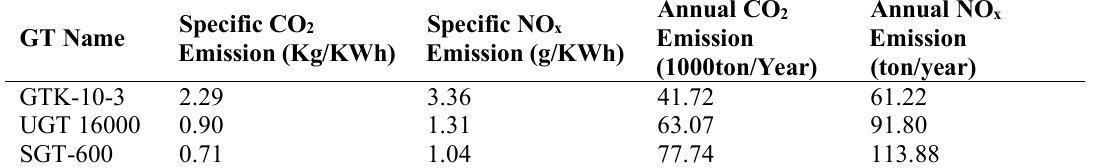
Table 7 . Emissions of each Polkalleh CS